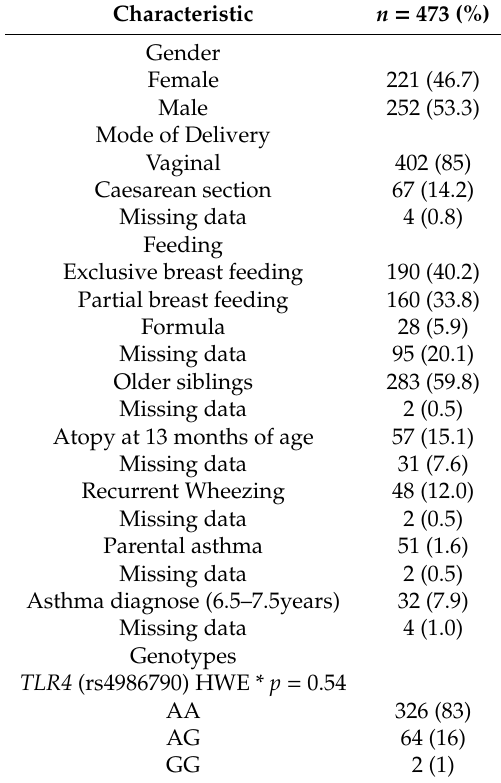
Table 1. Characteristic of the study